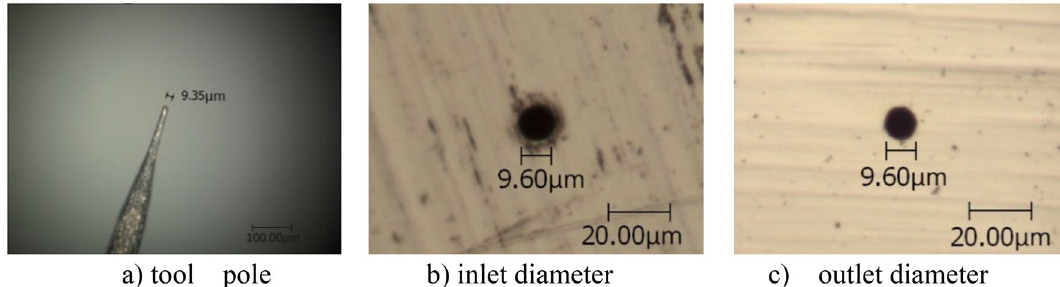
Figure 2. Micro holes produced for various k 1 = 0 and k 2 = 1.2.